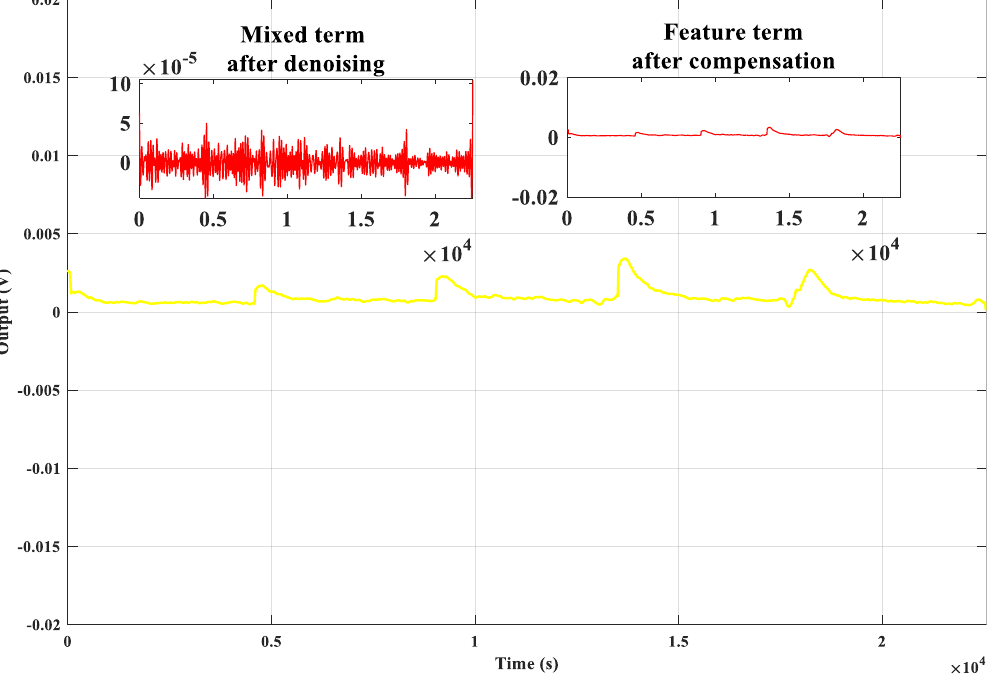
Figure 16. The compensation signal after reconstructing.